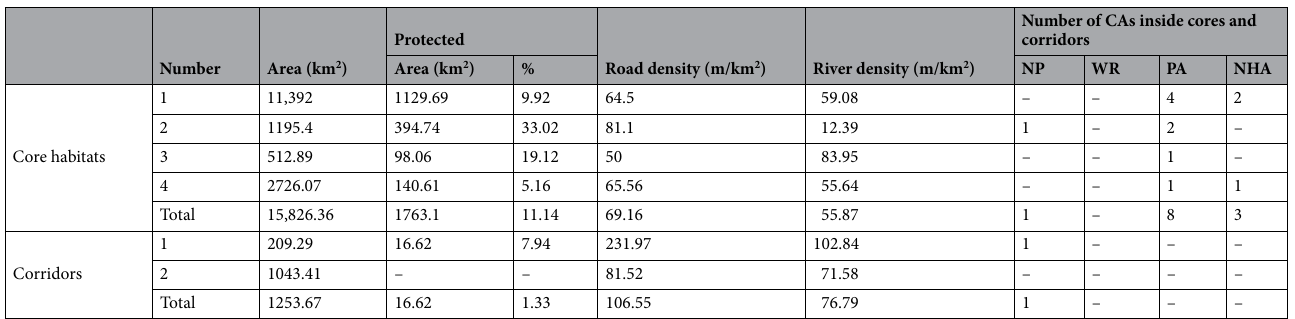
Table 3. Properties of predicted core habitats and corridors for the striped hyaena in the study area (number of core habitats and corridors are available at Fig. 4).